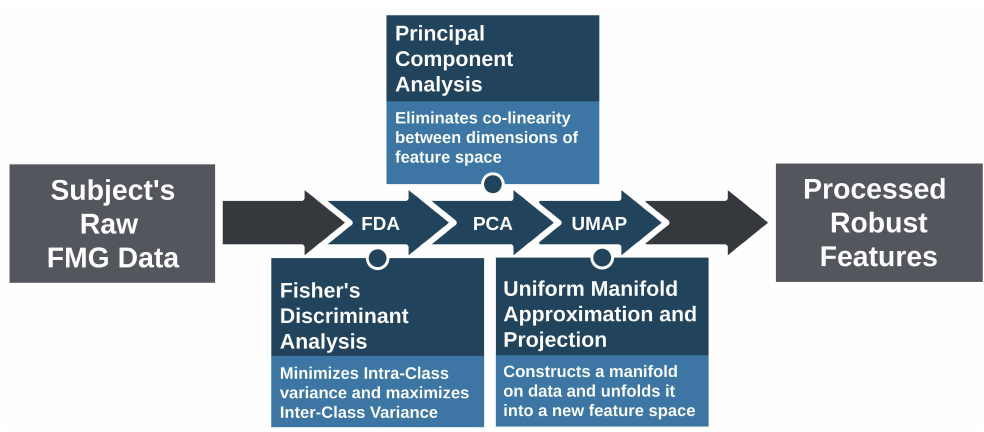
Figure 1. Schematic drawing of the pipeline design. FDA model minimizes the intra-class variance and maximizes the inter-class variance; PCA model removes correlation between data dimensions; UMAP model constructs a manifold on the data and unfolds it into a new feature